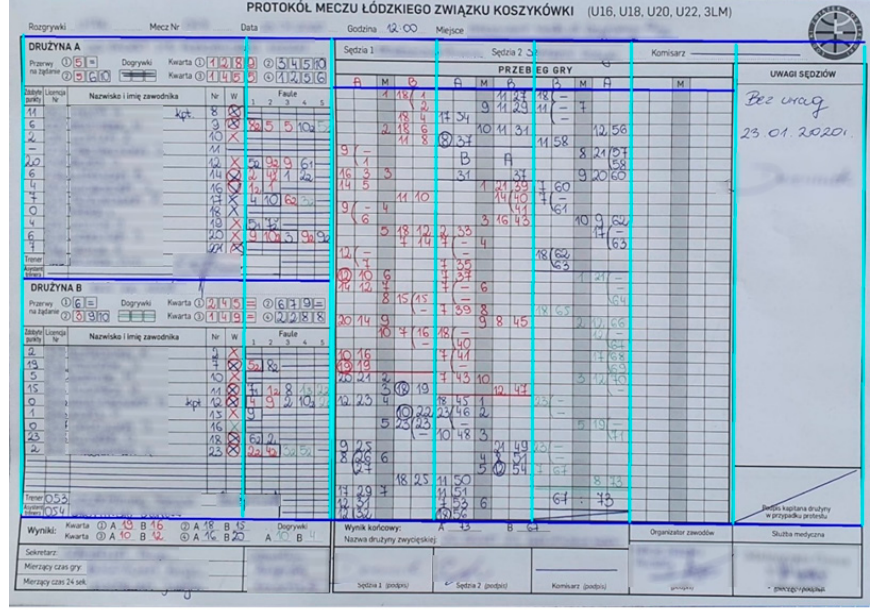
Figure 8. Main lines identified on the protocol.